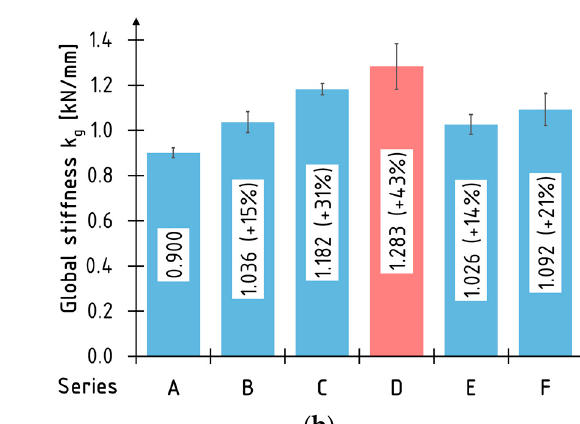
Figure 19. Average values of stiffness coefficients: ( a ) local k l ; ( b ) global k g .